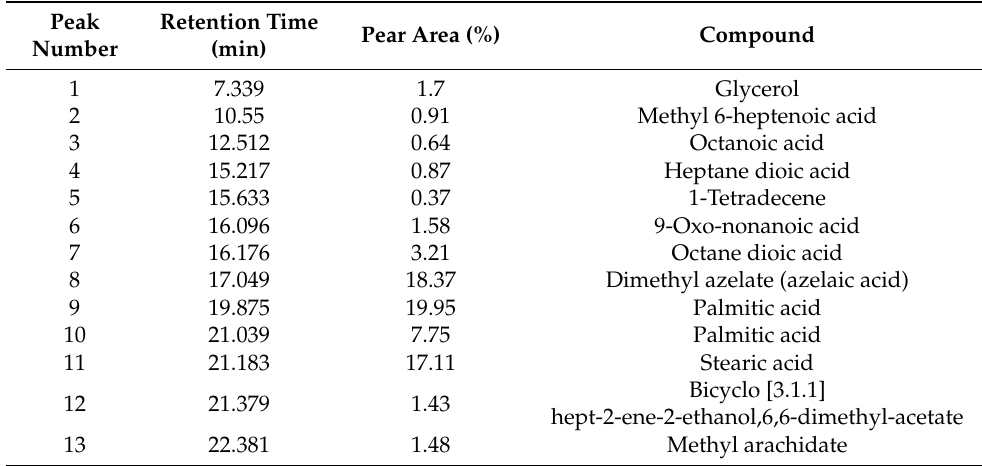
Table 4. Composition of compound of mortar